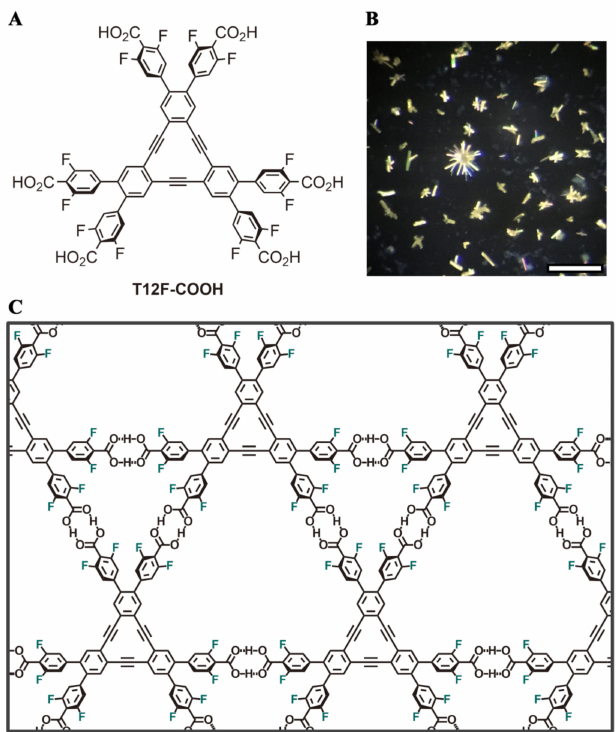
Figure 1. ( A ) Molecular structure of T12F-COOH. ( B ) Polarized optical microscope images of the hydrogen-bonded organic framwork (HOF) crystals. Scale bar: 100 µ m ( C ) Illustration of the H-bond interactions between the molecular units producing the T12F-1(124TCB)